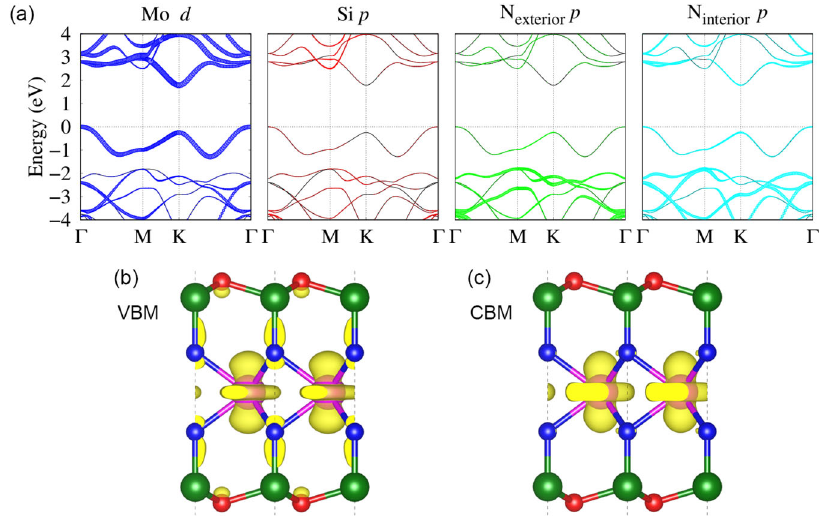
Fig. 3 Atomic character of the near band edge states of MoSi 2 N 4 . a Decomposition of Bloch wave function of MoSi 2 N 4 into atomic contributions, b the isosurface charge density plot ð ρ ¼ 0 : 02 e = Å 3 Þ for the top of the valence band at the K point, and c the isosurface charge density plot for the bottom of the conduction band at the K